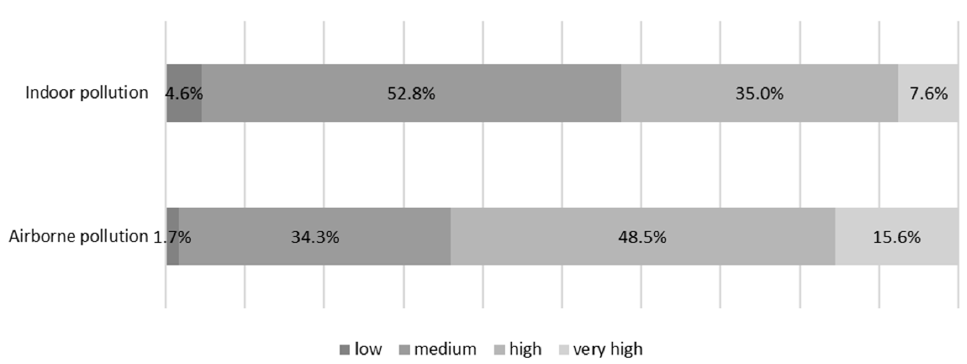
Figure 1. Perception of risks of the French on indoor pollution and airborne pollution.